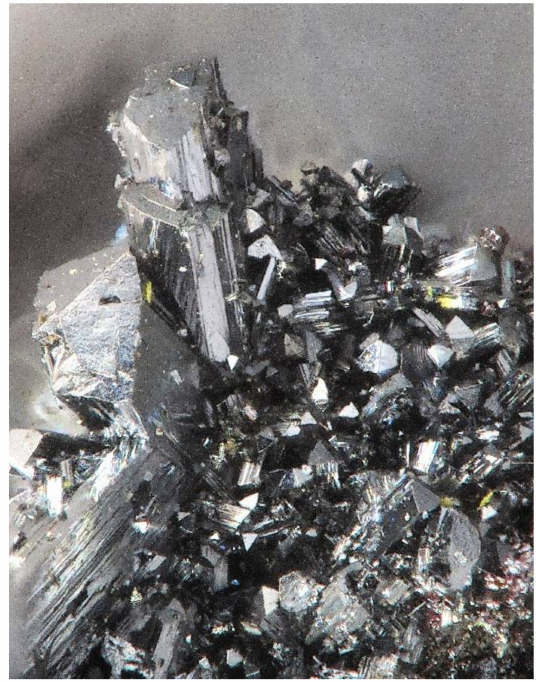
Figure 1. Andorite-like minerals occurring with orpiment on calcite. The crystals are not a single phase but a mixture of mainly different andorite-group minerals (i.e., oyonite, menchettiite, . . . ). The width is 1 mm. Photo by Christian